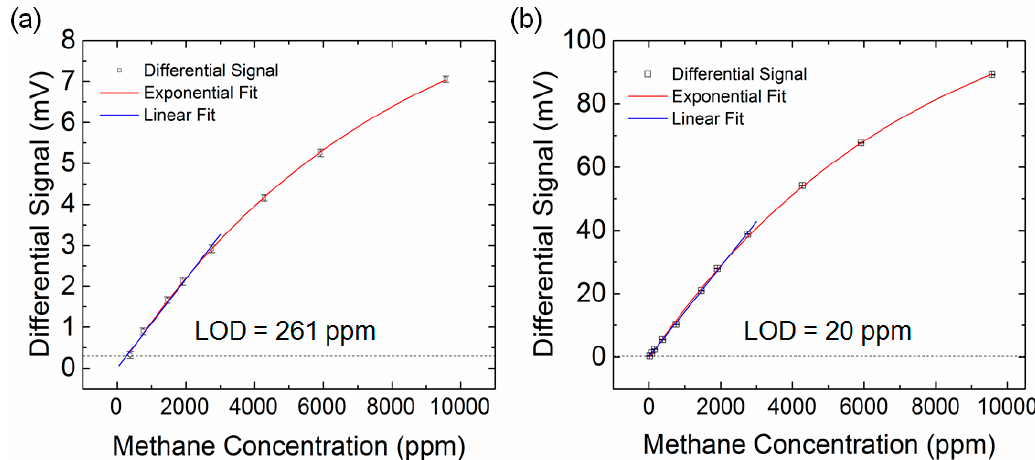
Figure 6. ( a ) The differential signals of the pyroelectric IR detector as a function of methane gas concentration before adding the plasmonic crystal structure. The red curve is an exponential fit of the differential signals and the blue curve is a linear fit of the differential signals. The LOD of the methane gas sensing system is determined by the intersection of straight line (blue) and the dashed line (black) at three times of the noise floor (0.3 mV); ( b ) The differential signals of the pyroelectric IR detector as a function of methane gas concentration after adding the plasmonic crystal structure. The red curve is an exponential fit of the differential signals and the blue curve is a linear fit of the differential signals. The LOD of the methane gas sensing system is determined by the intersection of straight line (blue) and the dashed line (black) at three times of the noise floor (0.3 mV).